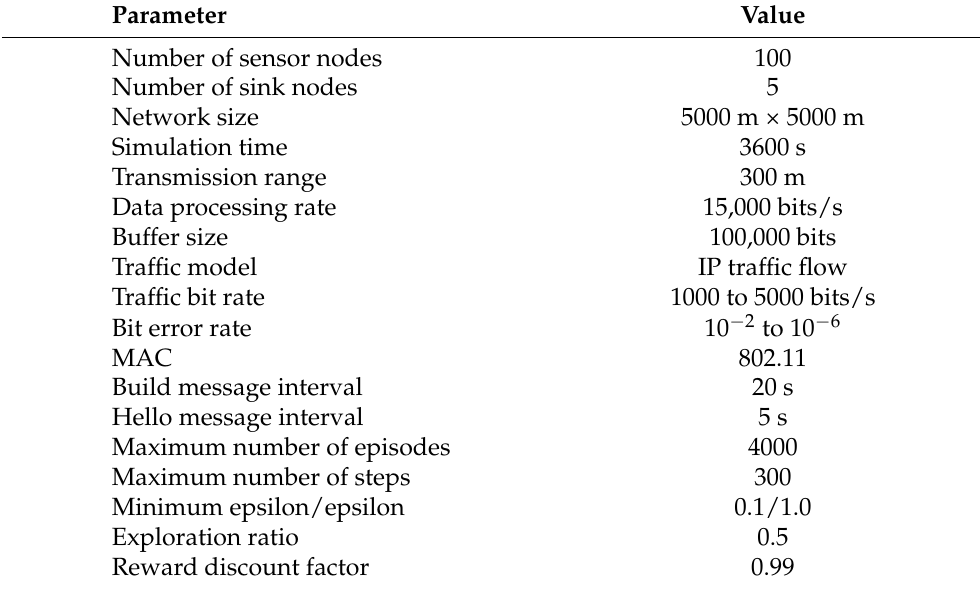
Table 1. Simulation